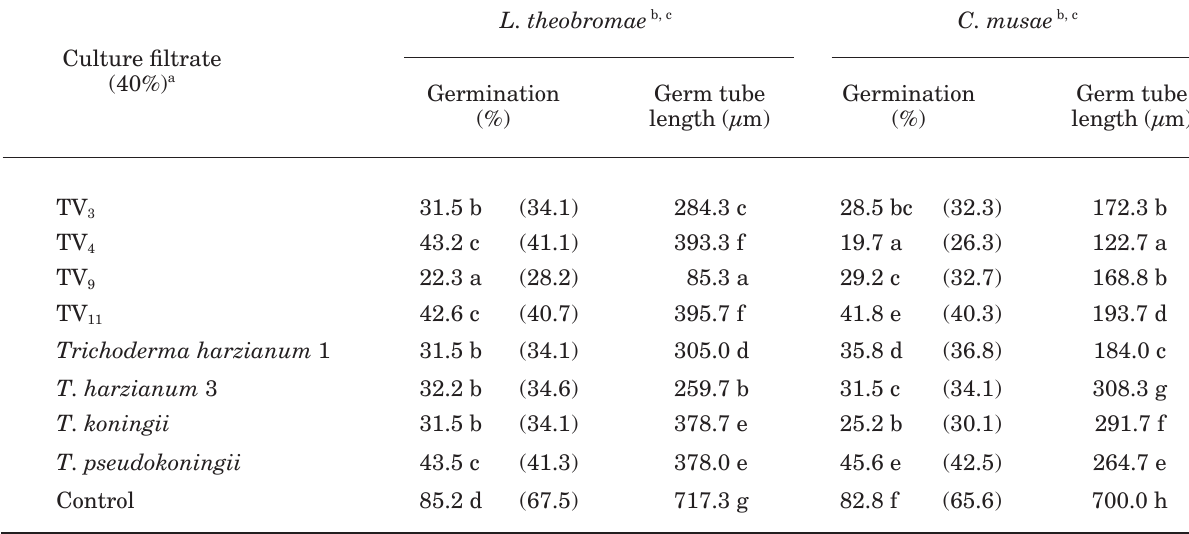
Table 3. Mean percent germination and germ tube length of conidia of Lasiodiplodia theobromae and Colletotrichum musae sprayed with culture filtrates of different Trichoderma spp.